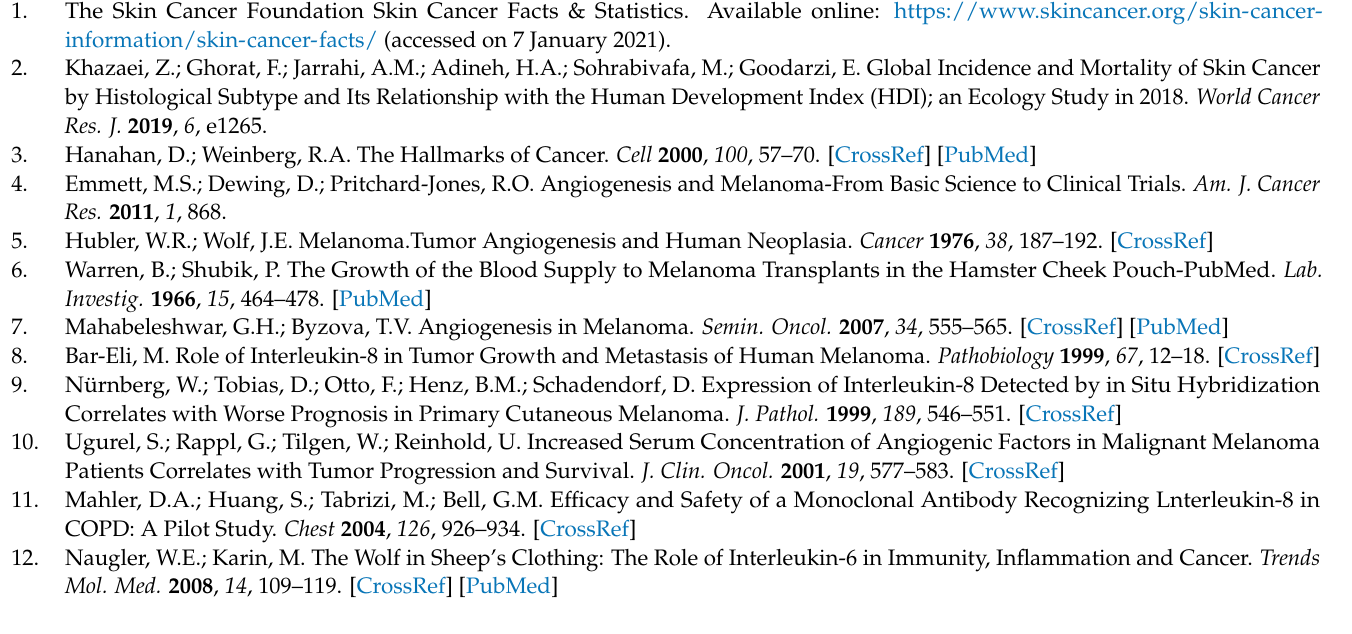
chromatogram (XIC) of m / z 455.35 in negative ionization mode of LC-MS analysis of (a) DT-BS-01 (b) Oleanolic acid and (c) Ursolic acid; Figure S3: Extracted-ion chromatogram (XIC) of m / z 479.35 in positive ionization mode of LC-MS analysis of (a) DT-BS-01 (b) Oleanolic acid and (c) Ursolic acid; Figure S4: Negative ionization mode mass spectra of (a) DT-BS-01 (b) Oleanolic acid and (c) Ursolic acid; Figure S5: Positive ionization mode mass spectra of (a) DT-BS-01 (b) Oleanolic acid and (c) Ursolic acid; Figure S6: Synthesis process of nanoparticles using Buddleja saligna ; Figure S7: Characterization of BS-AuNPs. (a) UV-Vis absorption spectra. (b) In vitro stability in buffer solutions after 24 h. (c) In vitro stability in buffer solutions after 48 h. (d) Transmission electron micrograph. (e) Particle size distribution; Figure S8: Characterization of BS-AgNPs. (a) UV-Vis absorption spectra. (b) In vitro stability in buffer solutions after 24 h. (c) In vitro stability in buffer solutions after 48 h. (d) Transmission electron micrograph. (e) Particle size distribution; Figure S9: Characterization of BS-PdNPs. (a) UV-Vis absorption spectra. (b) Transmission electron micrograph. (c) Particle size distribution (d) In vitro stability in buffer solutions after 24 h. (e) In vitro stability in buffer solutions after 48